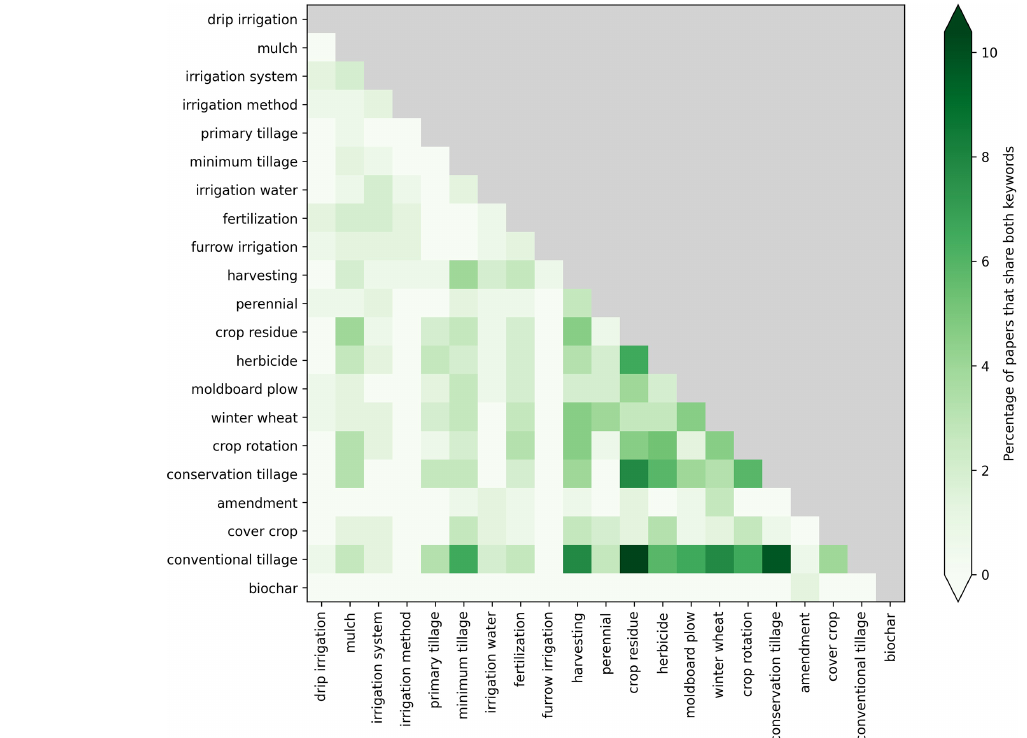
Figure 6. Co-occurrence matrix of identified management practices from the OTIM corpus.